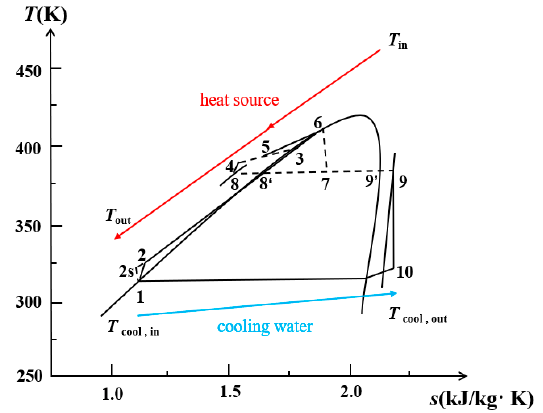
Figure 4. The T-S diagram of mixtures of the OFRC system.